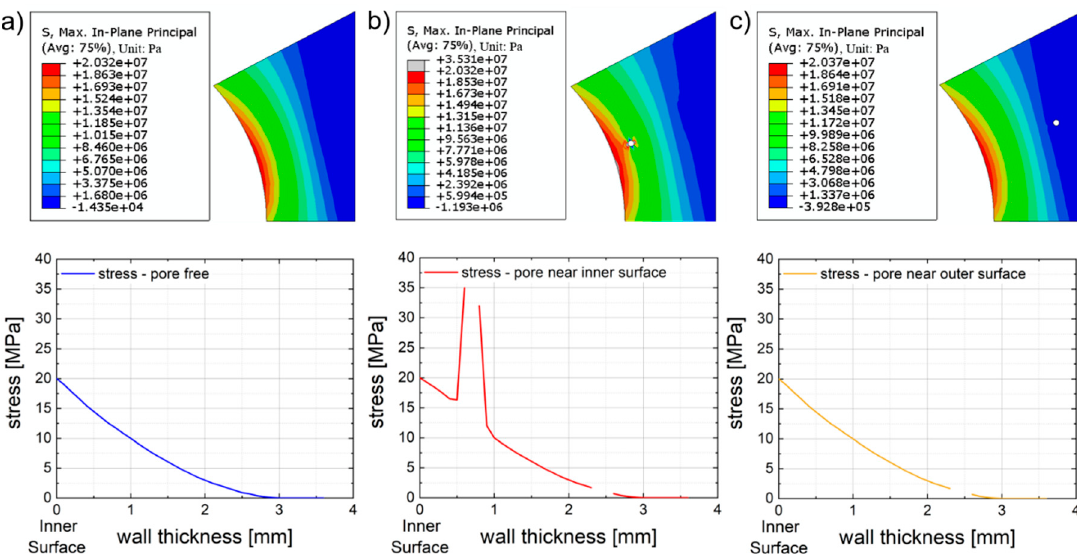
Figure 6. Stress distribution in ( a ) a pore free component, ( b ) a pore near the inner surface of the component, and ( c ) a pore near the outer surface of the component and through the wall (internal pressure 10 bar) [20].